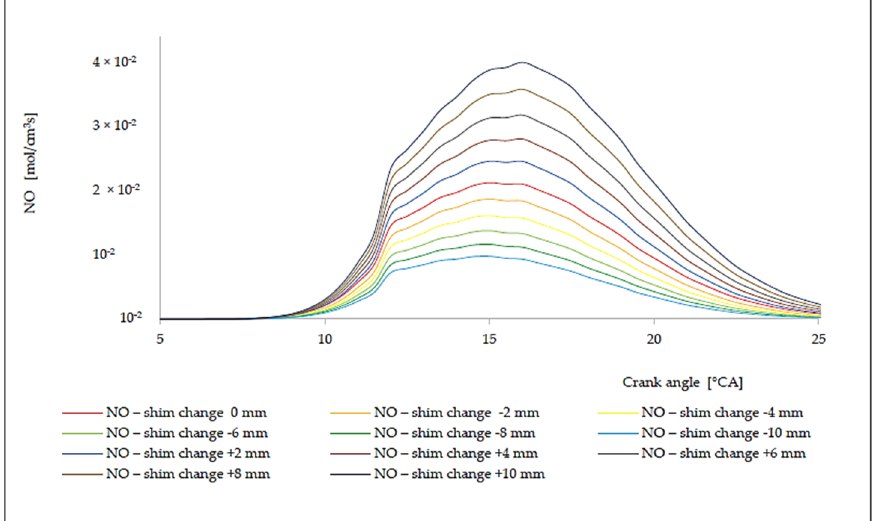
Figure 14. Dependence of NO concentration on the change in compression ratio at 75% MCR [22].